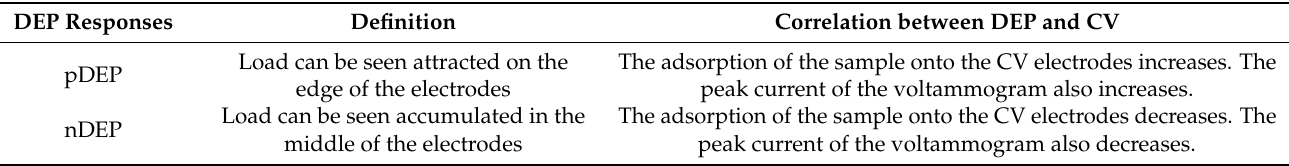
Table 7. Correlation between DEP responses with